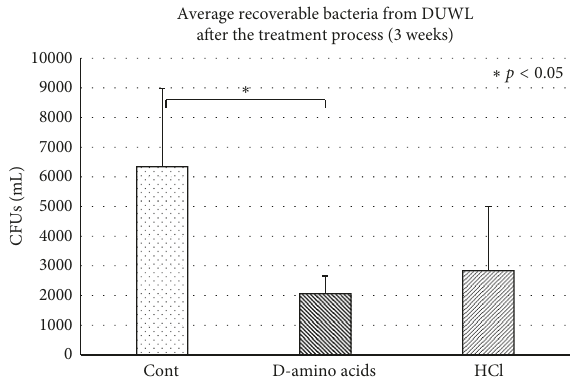
Figure 6: The average bacterial count in output water of the DCUs collected during the last 3 weeks after treatment of the DUWLs with distilled water (control), D-amino acids mixture (D-amino acids, 10mM each), or 0.1M HCl for 5 days. ∗ Statistically different at p < 0 .